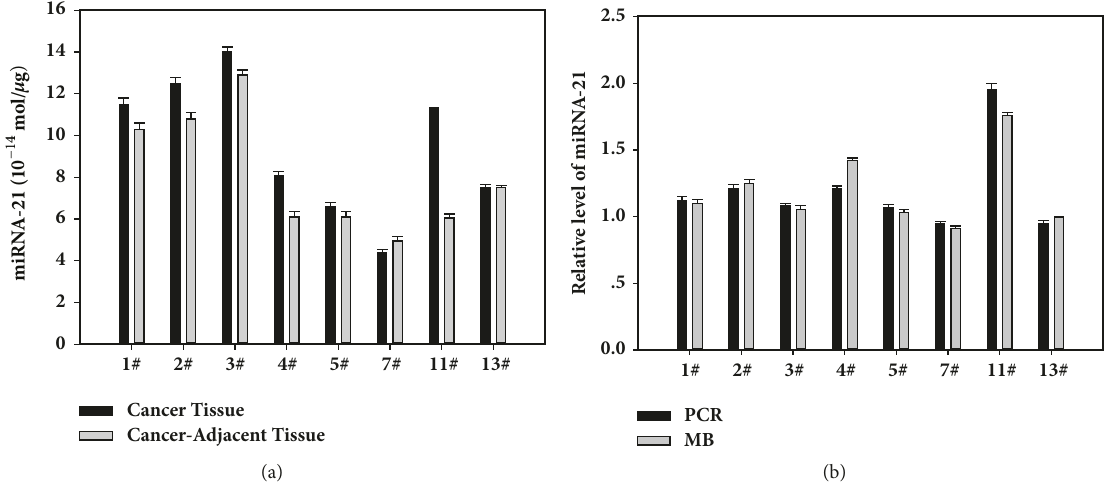
Figure 6: Detection of miRNA-21 in gastric cancer tissue by molecular beacon (a) and qRT-PCR